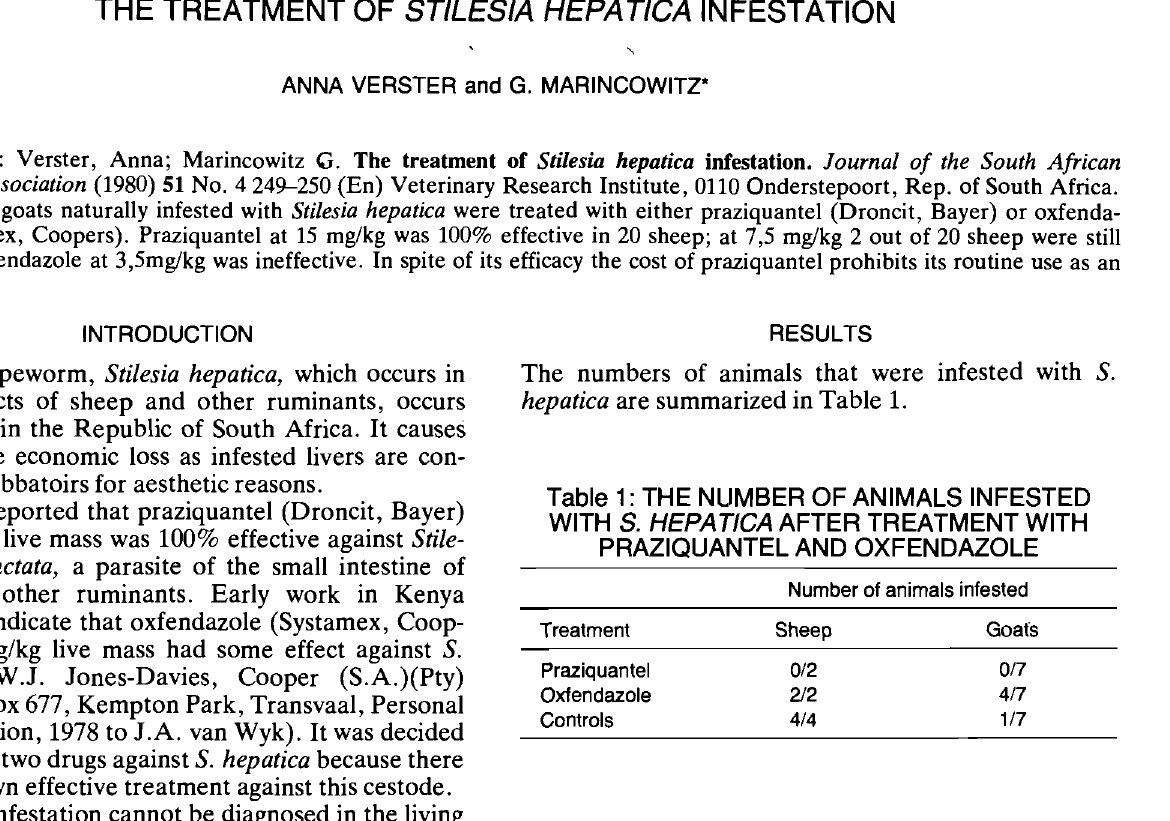
Table 1: THE NUMBER OF ANIMALS INFESTED WITH S. HEPATICA AFTER TREATMENT WITH PRAZIQUANTEL AND